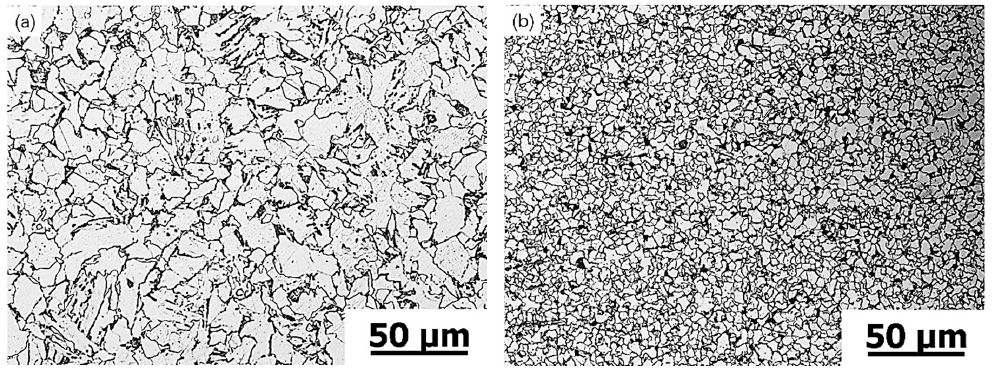
Figure 4. HAZ microstructure of testing steel: ( a ) with V; and ( b ) with Nb.